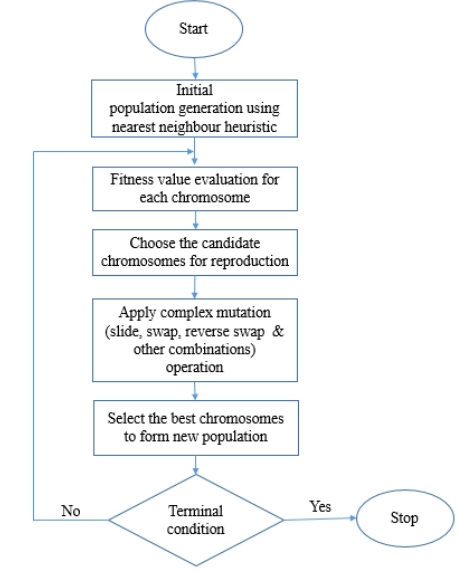
Fig. 8. Flowchart of the proposed GA